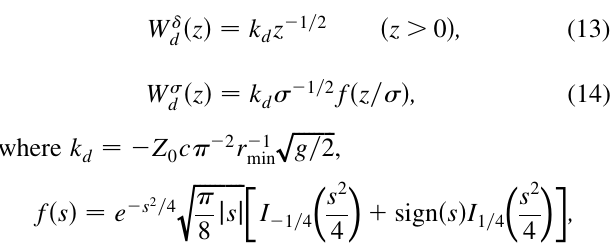
200 (cid:8) m ECHO result, and the ones directly calculated by ECHO for (cid:1) ¼ 100 and 50 (cid:8) m .